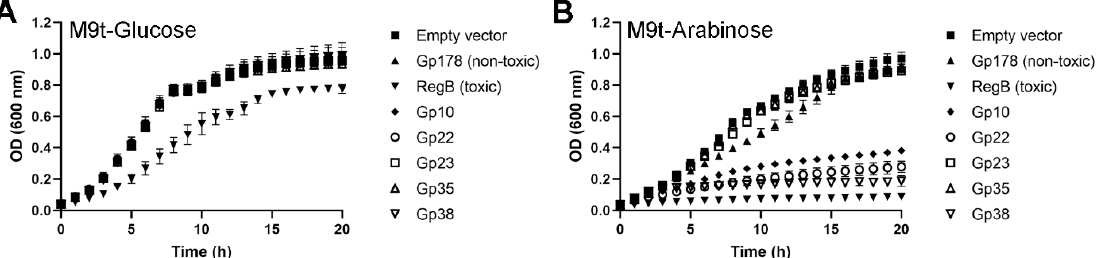
Figure 4. Toxic gene screening by transformation efficiency plating showing the average number of colony forming units (CFU) of transformants ( ± SD of two biological replicates) relative to that of g178 . The ligation mixtures of the pU11L4 backbone with the hypothetical proteins of unknown function (HPUF) genes of fHe-Kpn01 or the control genes regB (toxic, a restriction endoribonuclease gene from phage T4) or g178 (non-toxic) were electroporated into E. coli DH10B. For each ligation mixture, the number of transformants was determined from triplicate plating. The cut-off value for potentially toxic gene products (Gp) was set to 0.4 with maximum SD of 0.15.